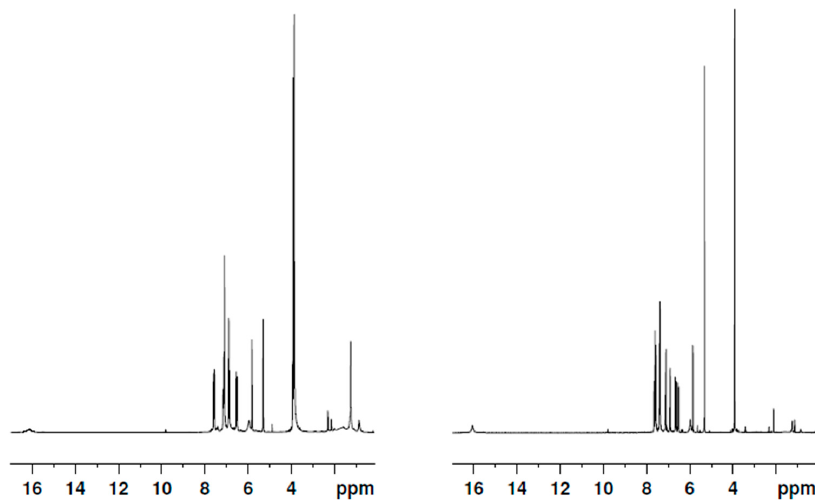
Figure 6. 1 H NMR spectra of 2 ( left ) and 3 ( right ) in dichloromethane- d 2 .